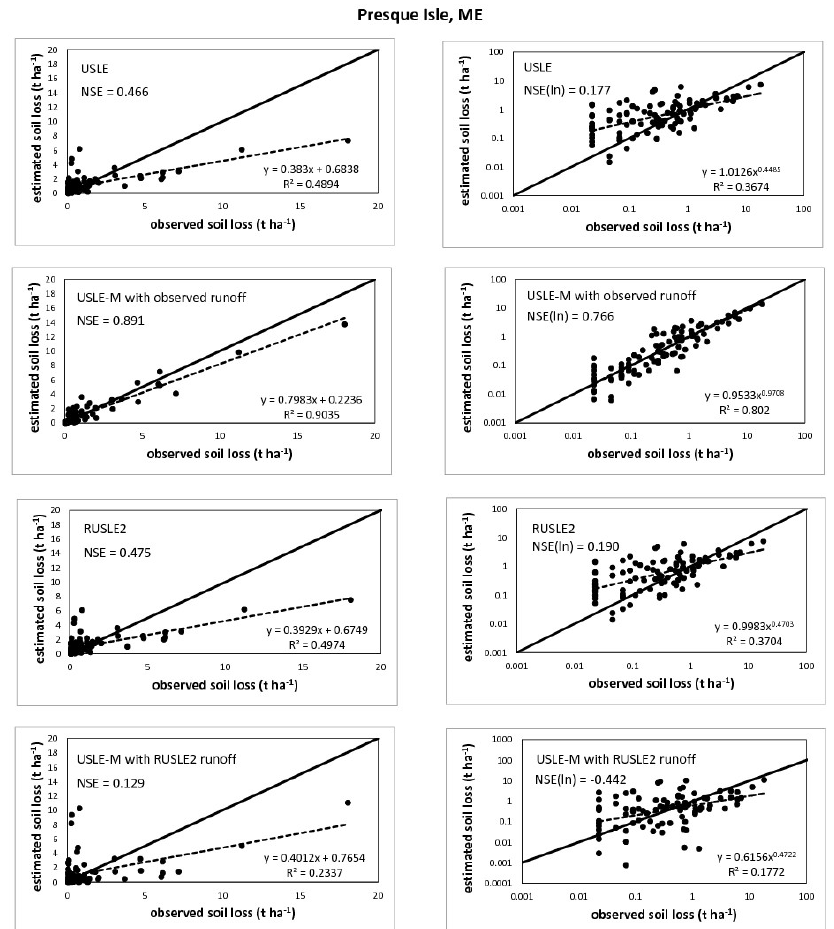
Figure 6. Relationships between observed and predicted event soil losses associated with the USLE, RUSLE2, and the USLE-M for bare fallow plots 1–3 at Presque Isle, ME. The solid line represents the 1:1 relationship between observed and predicted event soil losses (source: Kinnell [53]). Table 1. Nash–Sutcliffe efficiency index (NSE(ln)) values obtained soil loss predictions on the four bare fallow plots in the USLE database using the USLE, RUSLE2, and the USLE-M. All the plots were 22.1 m long (source: Kinnell [53]). OH: Ohio, TX: Texas.